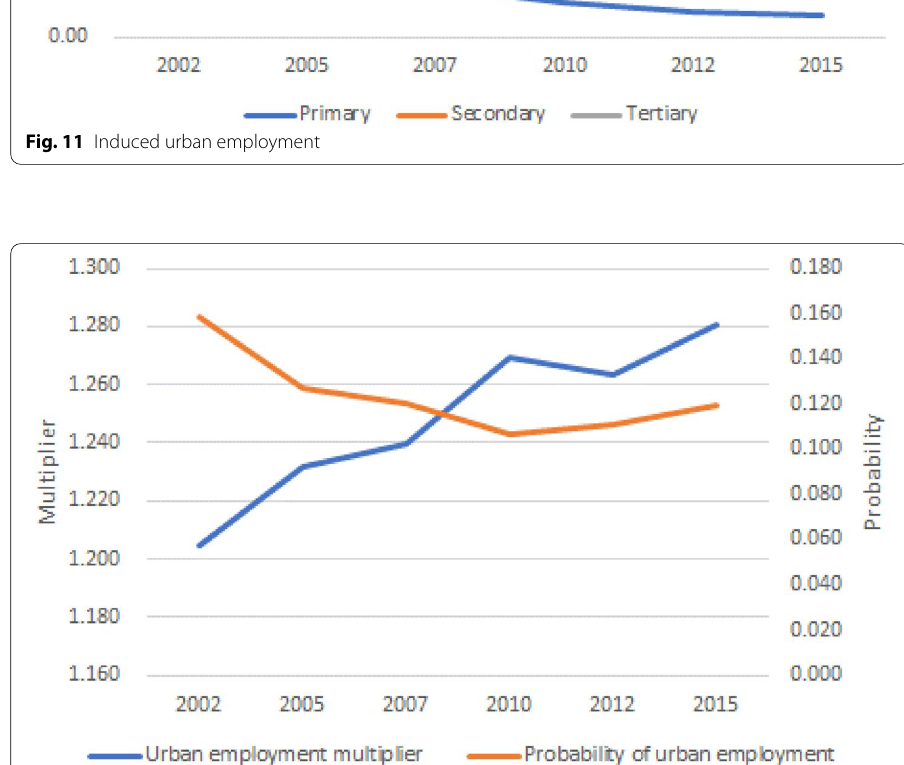
Fig. 12 Urbanization multiplier (urban and rural labor allocation